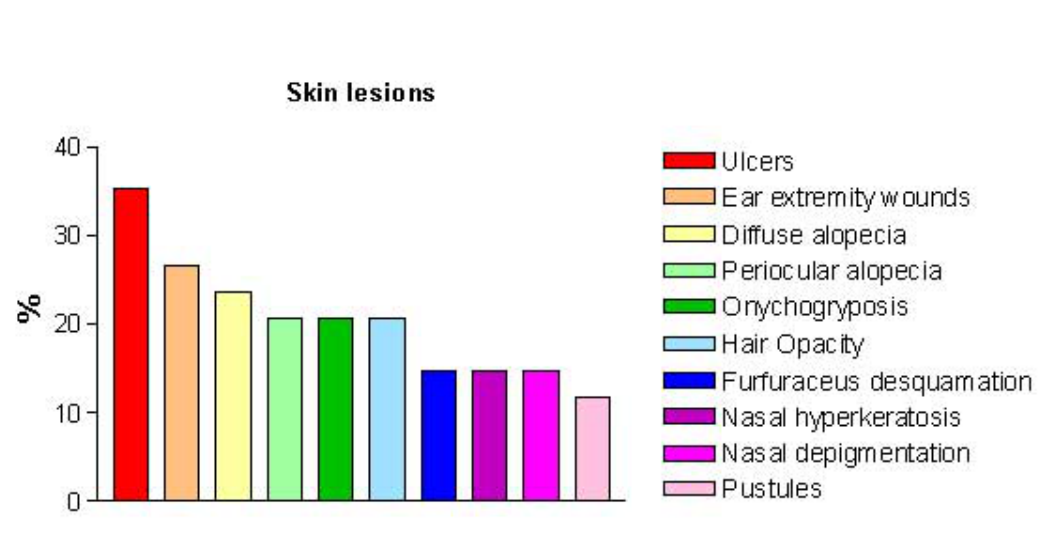
Figure 2: Frequency (%) of different skin lesions in symptomatic VL seropositive dogs (n=34) from Teresina, Piauí State, Brazil, 2002.